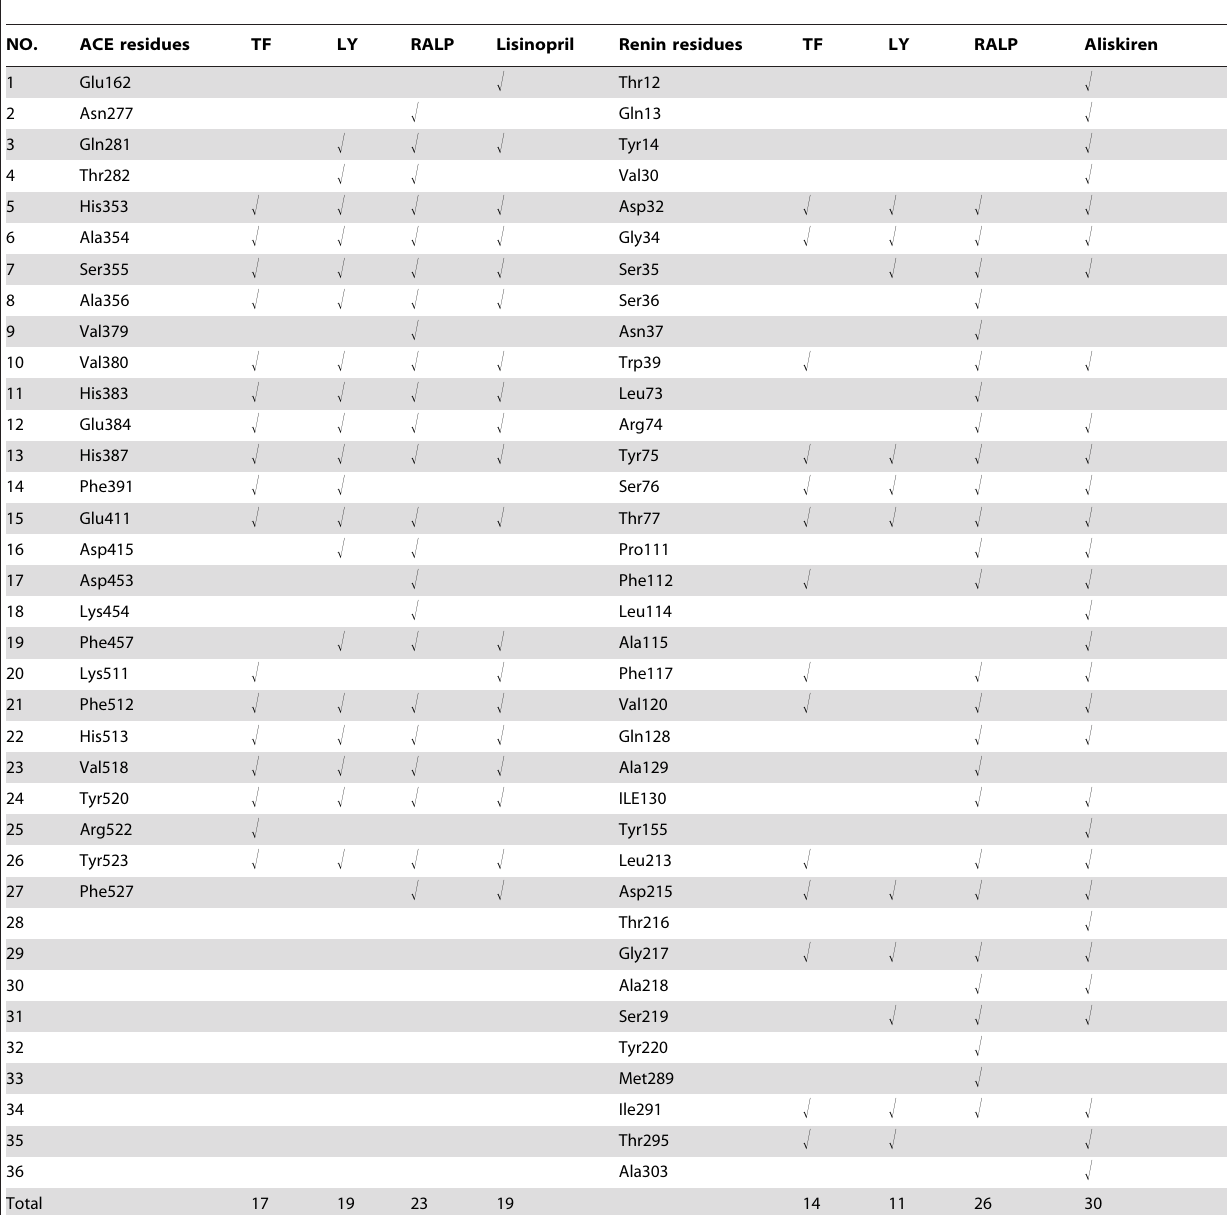
Table 4. ACE (PDB: 1O86) and renin (PDB: 2V0Z) residues having at least one atom at a distance of 3.5 A˚ around the docked